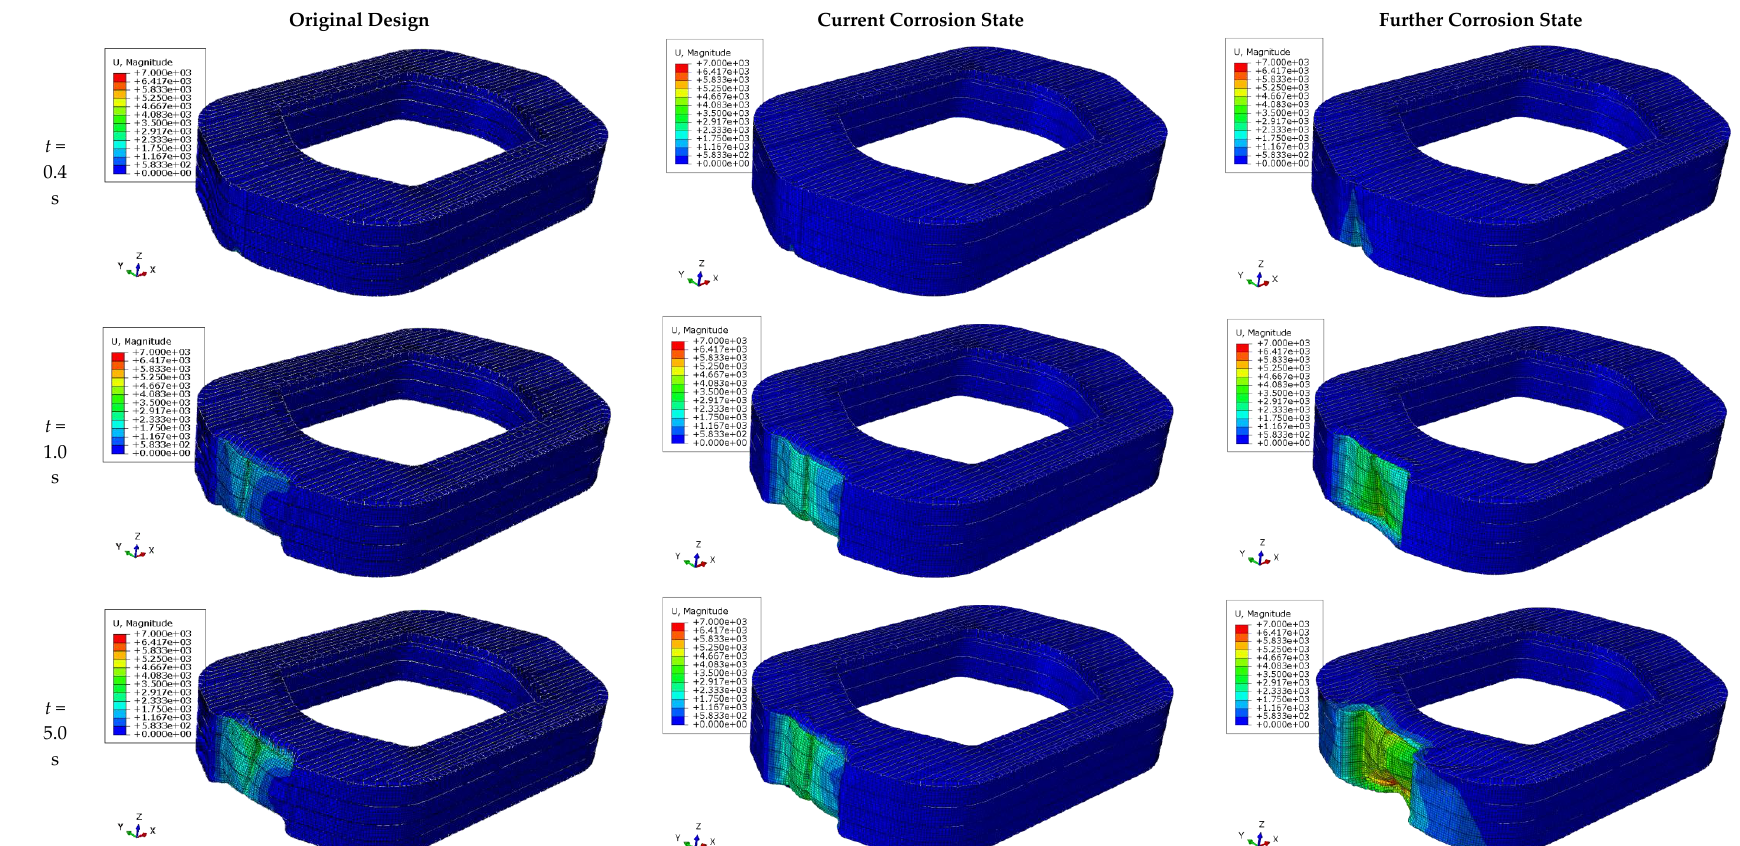
Figure 7. Deformation distribution in protective device during impact for original design, current corrosion state, and further corrosion state.